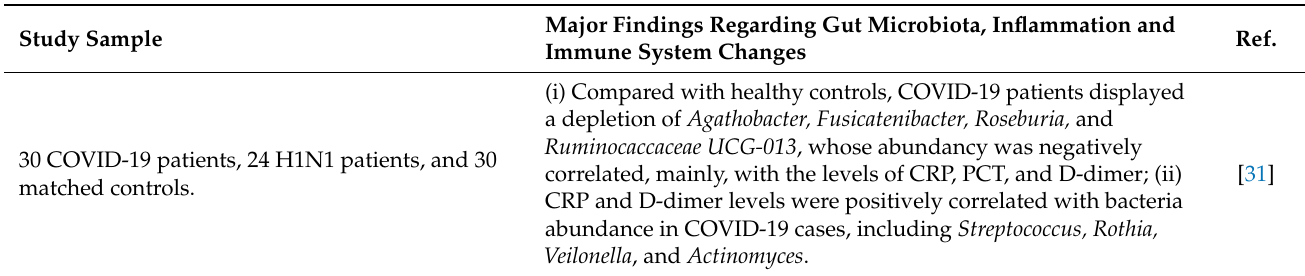
Table 1. Major findings regarding changes on gut microbiota, inflammation, and immune system markers in Coronavirus Disease 2019 (COVID-19) patients, and the suggested associations with disease severity. Study Sample Ref.